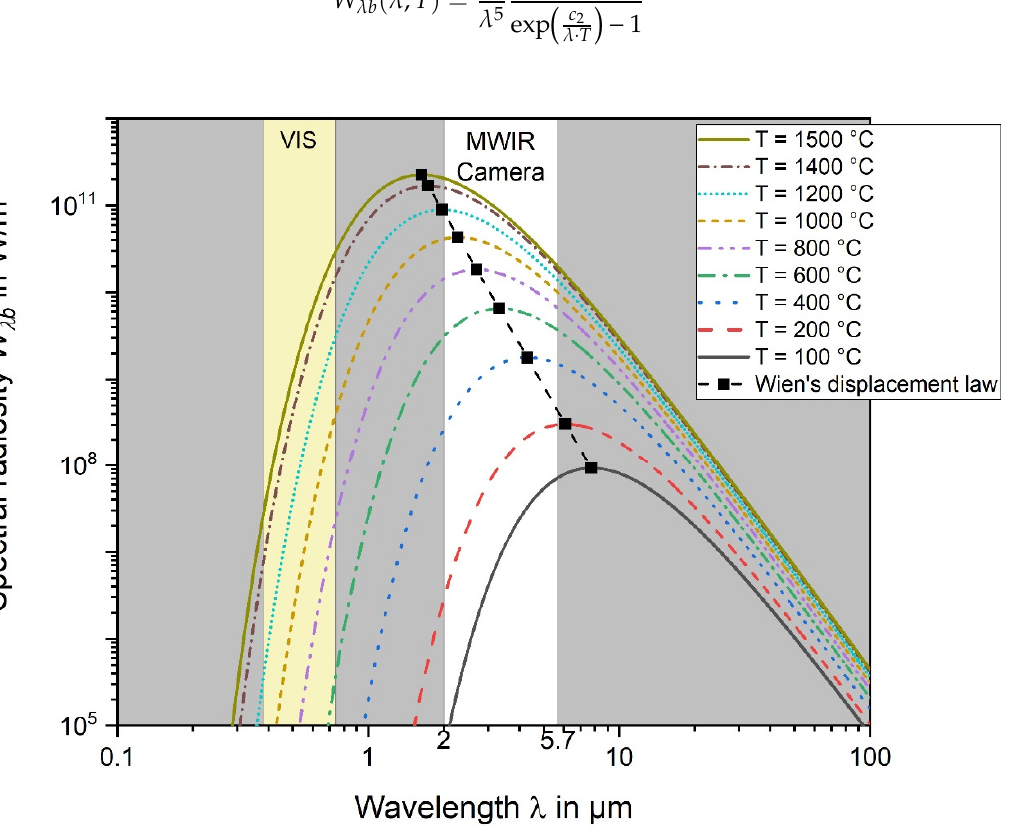
Figure 1. Planck’s law and Wien’s displacement law graphically expressed. The visible spectrum (VIS) and the mid-wavelength infrared (MWIR) region of the camera of this study are highlighted.